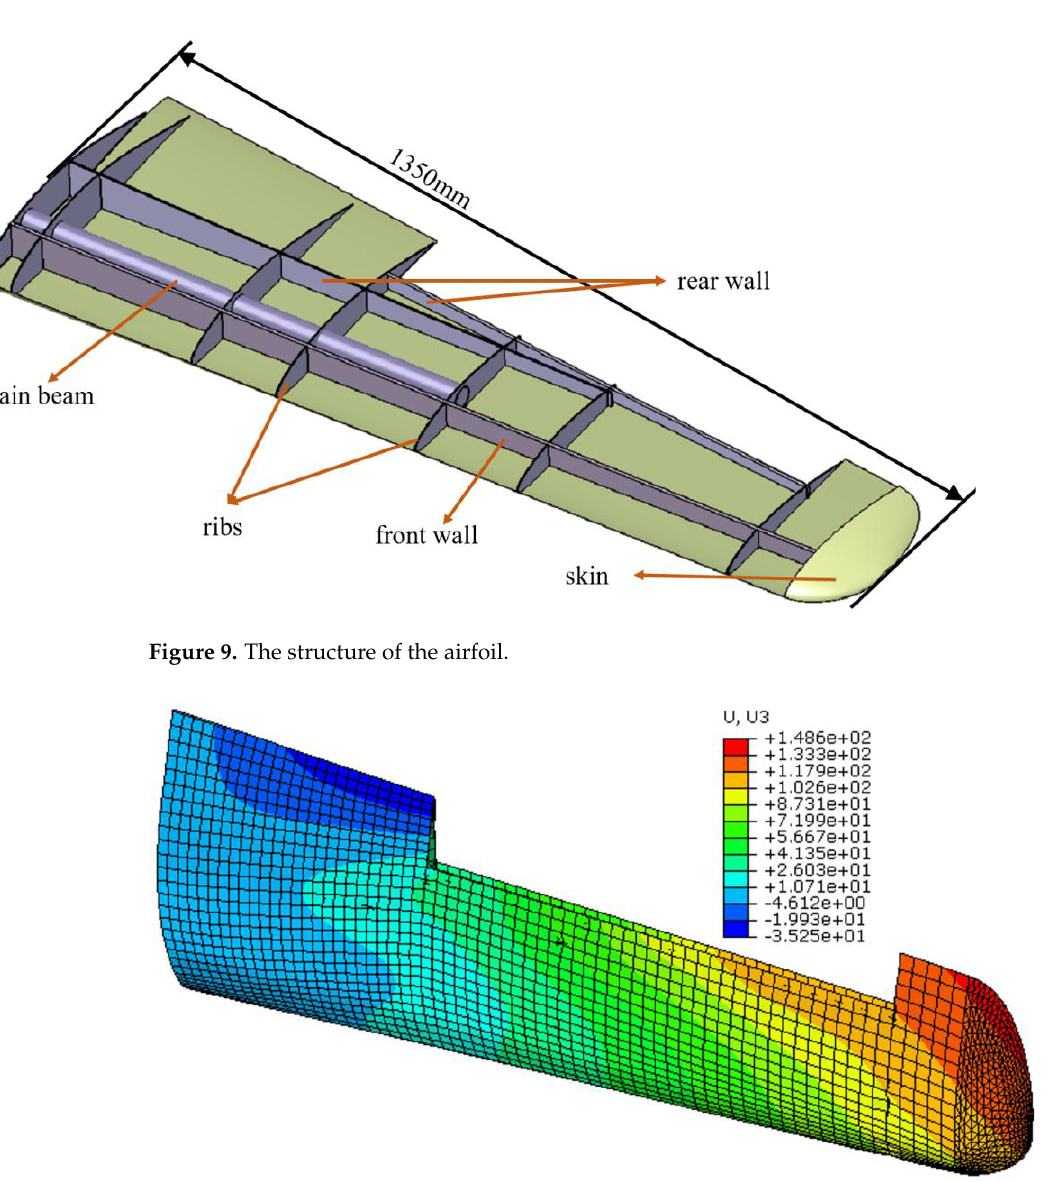
Figure 10. Displacement contour map of the aircraft wing. Table 5. The mean values and standard deviations for example 3.